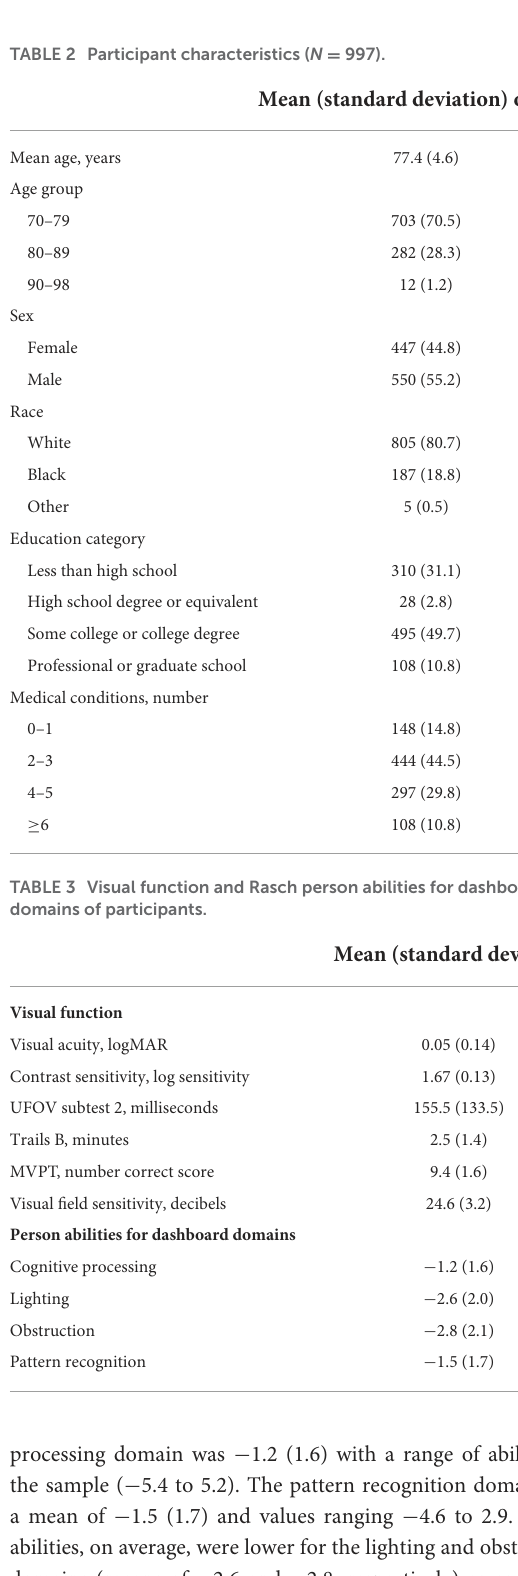
TABLE 2 Participant characteristics ( N = 997).